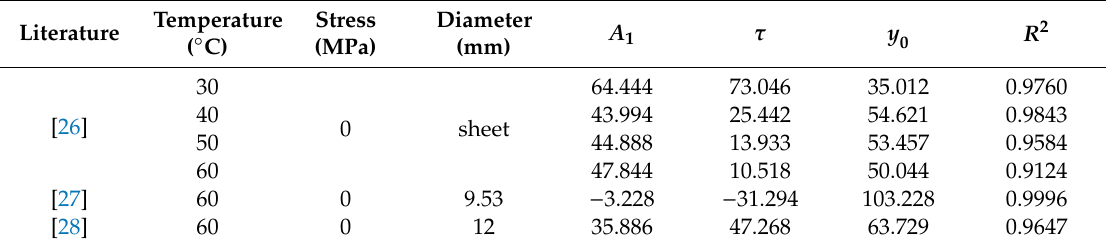
Table 5. Coefficient of modified model for fitting equation with experimental values of other studies.